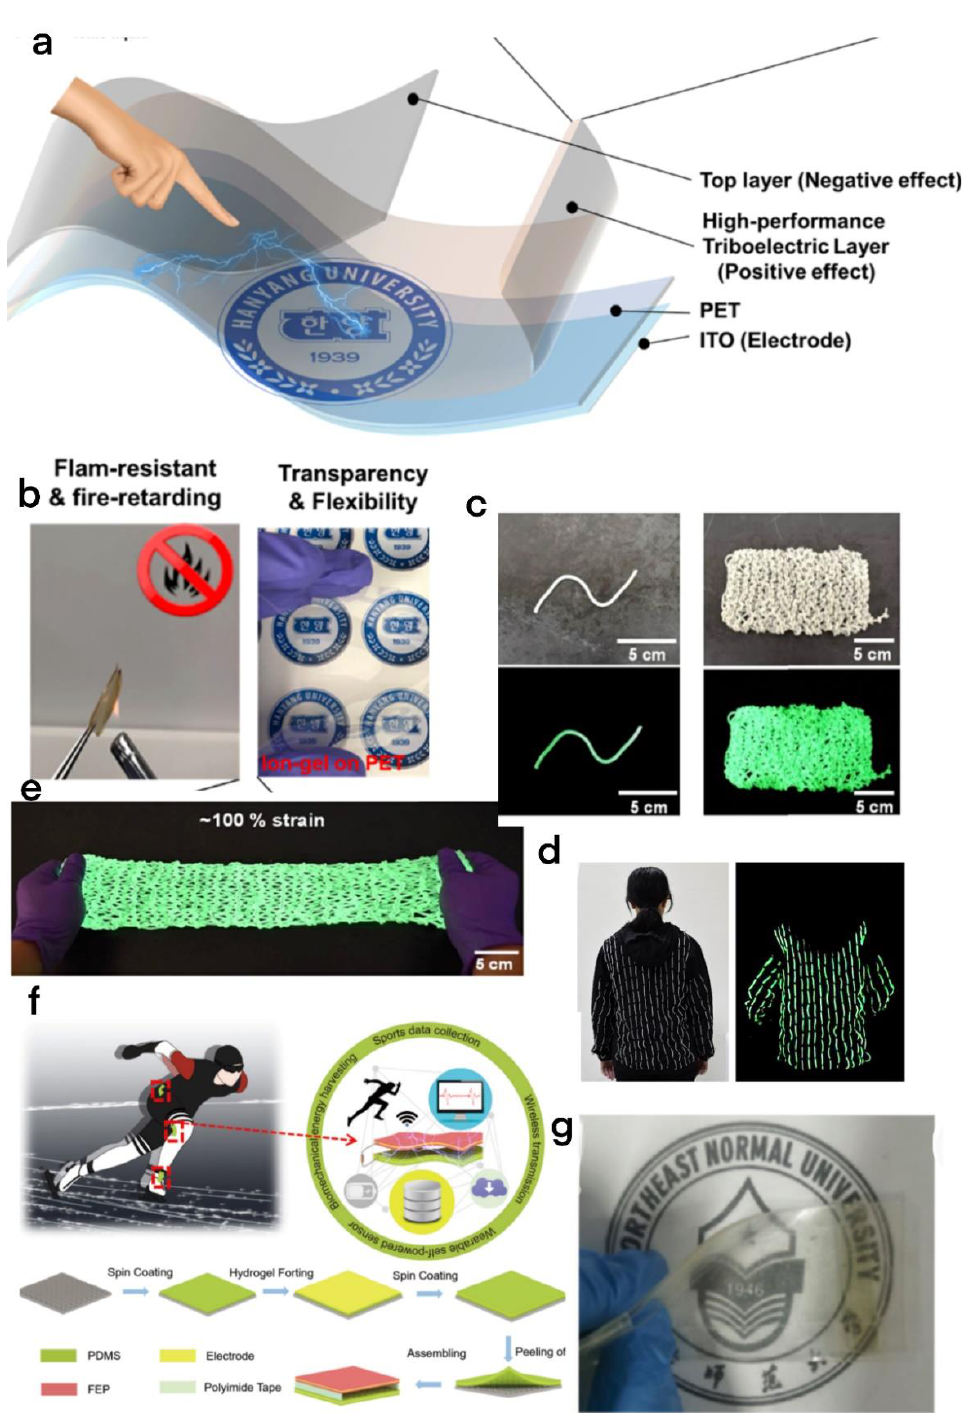
Figure 7. ( a ) Structural schematic diagram of the TENG system. ( b ) Flame retardancy and flexibility of the TENG device [59]. Kim et al. (2021), Elsevier. ( c ) Photos of SLEN-TF and knitted SLEN-TF-based textiles under natural light (upper) and dark (lower). ( d ) The photo of SLEN-TF textile clothing in the sun and dark. ( e ) Schematic diagram of flexibility and tensile properties of the SLEN-TF [62]. Li et al. (2022), Elsevier. ( f ) The application scene of the MS-TENG in speed skating and the manufacturing process of the MS-TENG. ( g ) The optical image of the MS-TENG in bending state [58]. Lu et al. (2022), MDPI.